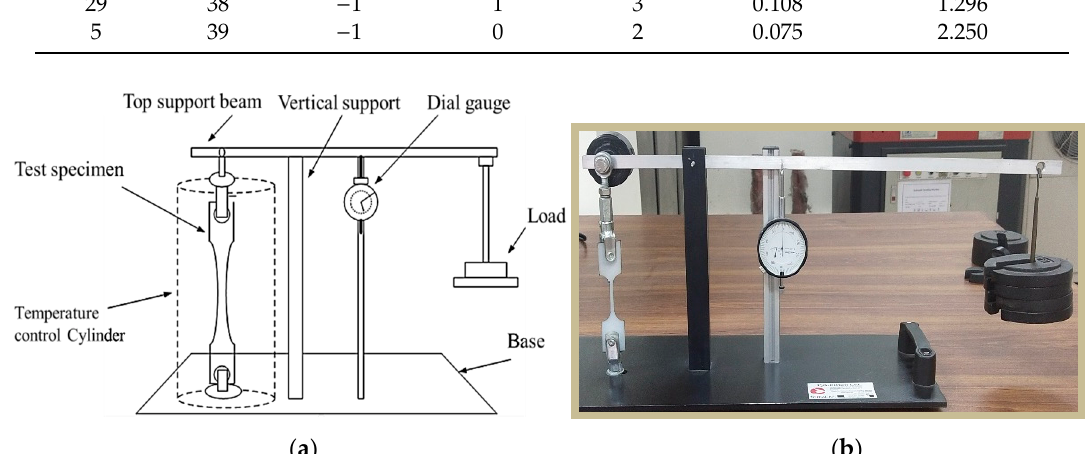
Figure 3. Creep testing machine. ( a ) Schematic diagram. ( b ) Actual setup.